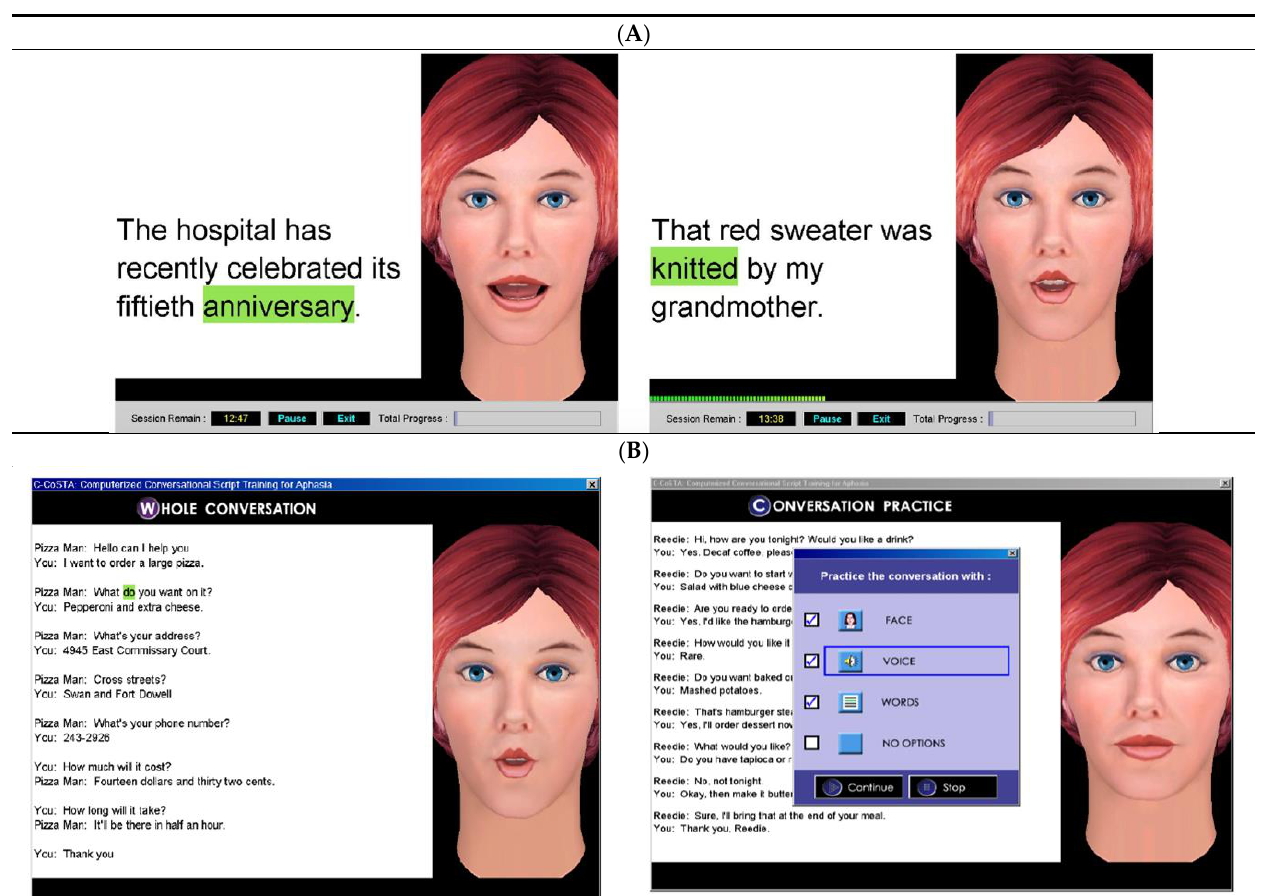
Figure 4. Sample screenshots showing the “virtual therapist” and examples of sentence and script stimuli in ( A ) AphasiaScripts ® and ( B ) ORLA ® . Words are highlighted in green as the virtual therapist reads the sentences aloud by herself and then in unison with the participant. When the participant reads the sentences aloud in unison and independently, the green highlighting of the words and the virtual therapist’s mouth movements provide cues that help with the accuracy and rate of production of the words and sentences. In AphasiaScripts ® , these cues can be removed one at a time during the conversation practice.